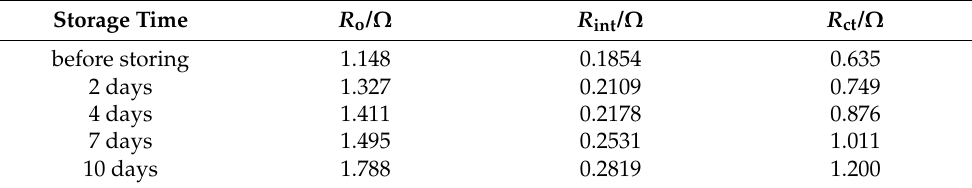
Table 1. Impedance data obtained by fitting the equivalent circuit diagram in the inset of Figure 2b. Storage Time